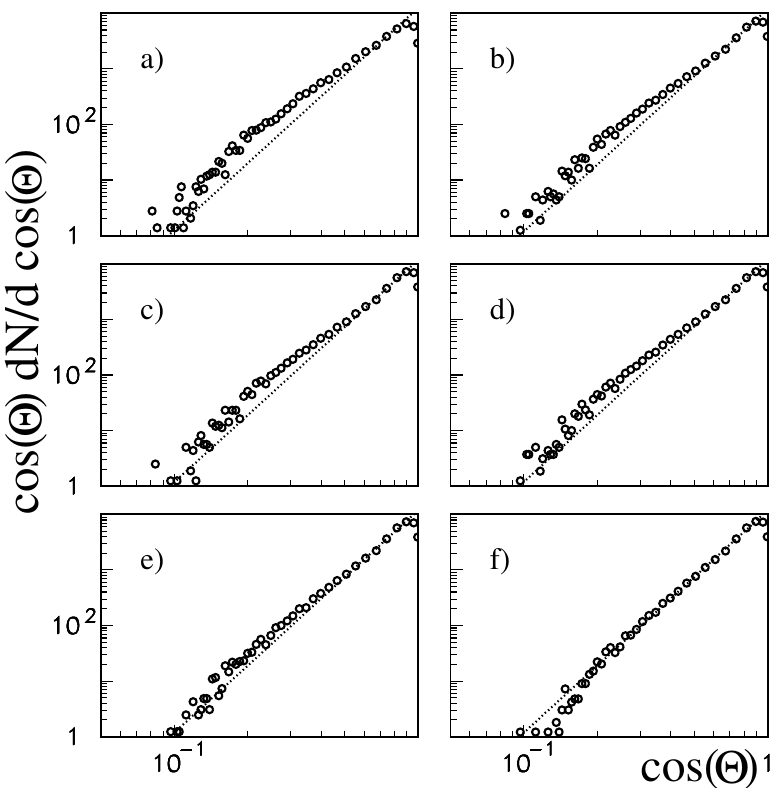
Figure 3. The observed distribution of cos ( Θ ) for camera sensitive layer depth h equal to 5 px for different track length determination procedures: ( a – f ) (see text for detaied explanation for subfigures). The dotted line represents the expected dependency of the form cos 2 ( Θ )